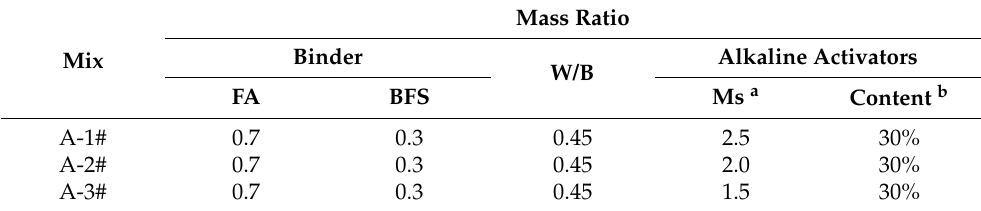
Table 3. Design of geopolymer pastes.